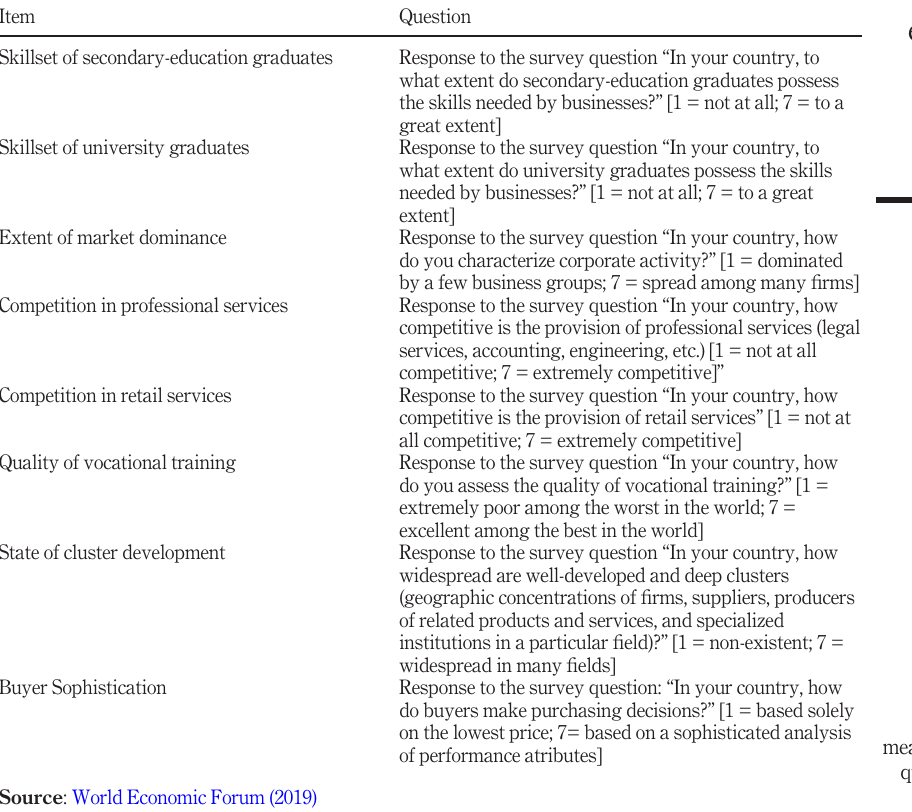
Table 3. Items used